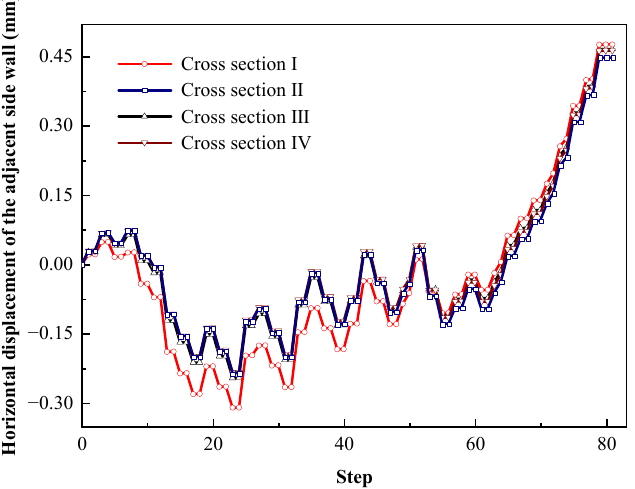
Figure 12. Horizontal displacement of the adjacent side wall of existed tunnel.